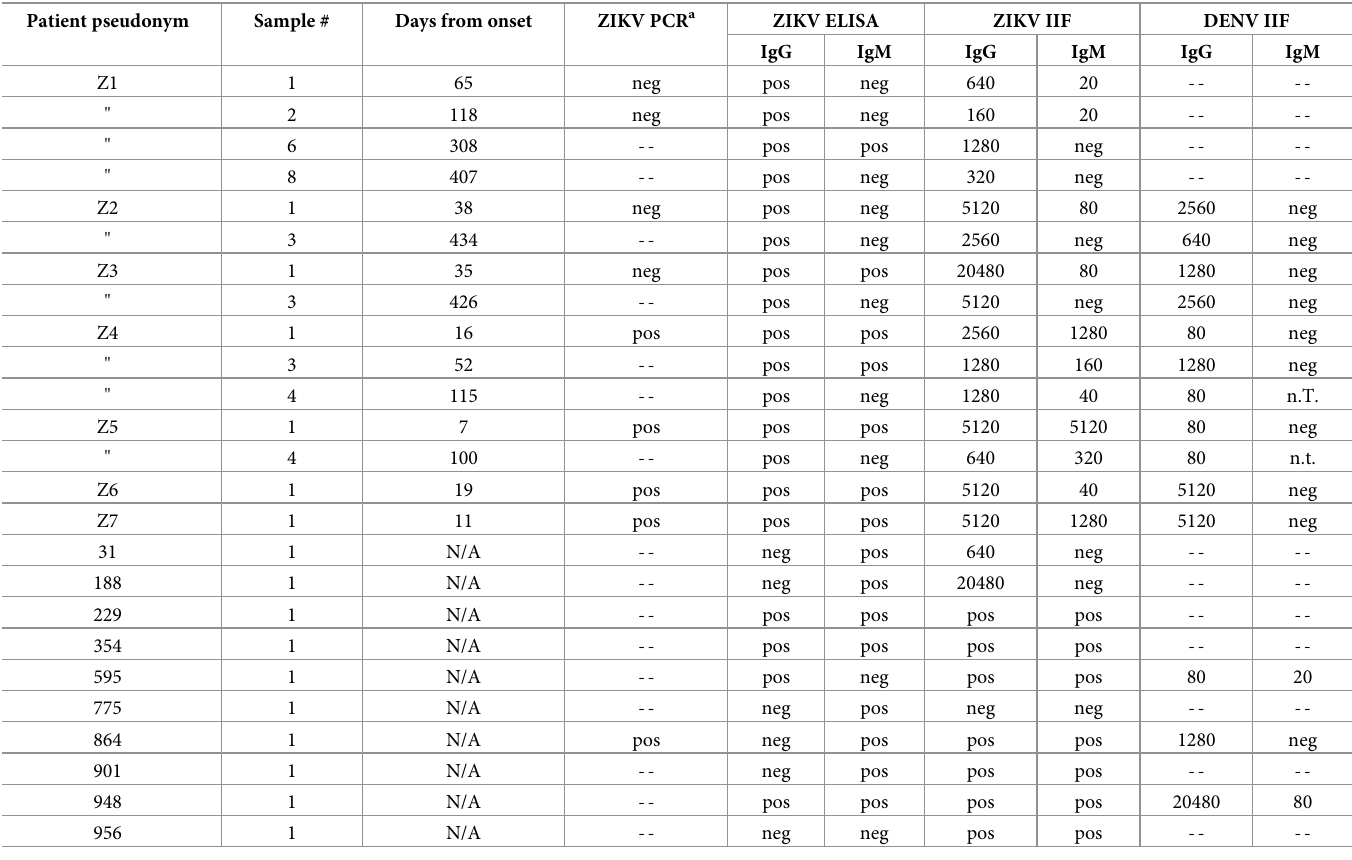
Table 1. Reference test results for ZIKV-positive